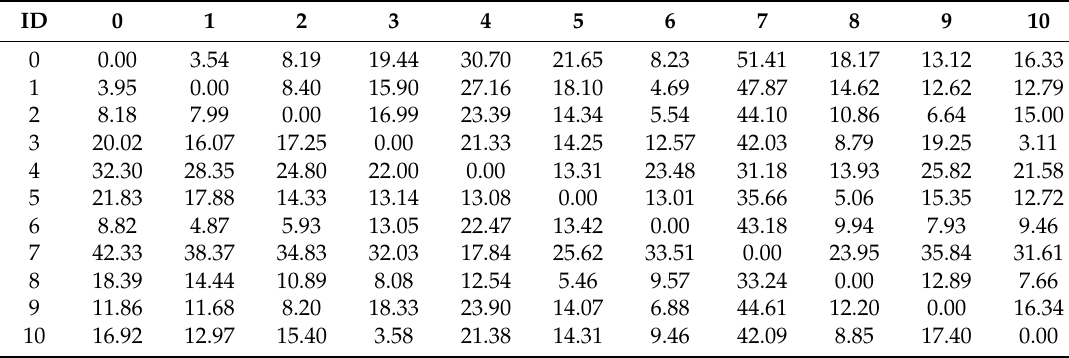
Table 3. Average travel times between the warehouse and flooded areas